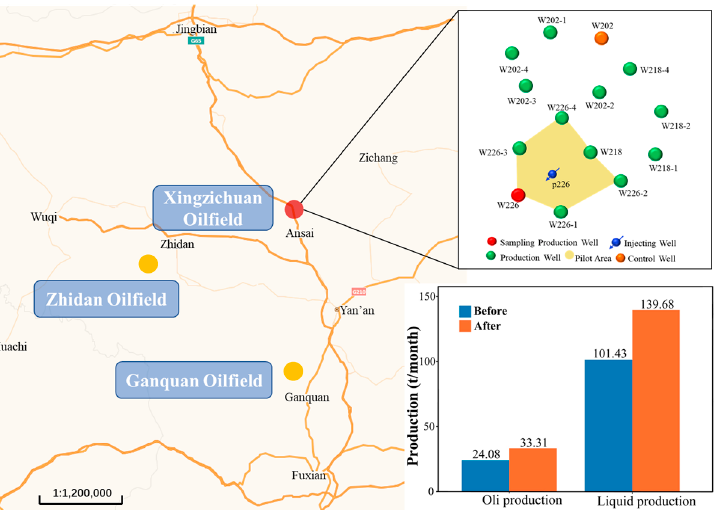
Figure 1. The location of the P226 test block and production changes in the production well W226 before and after nutrients injection.